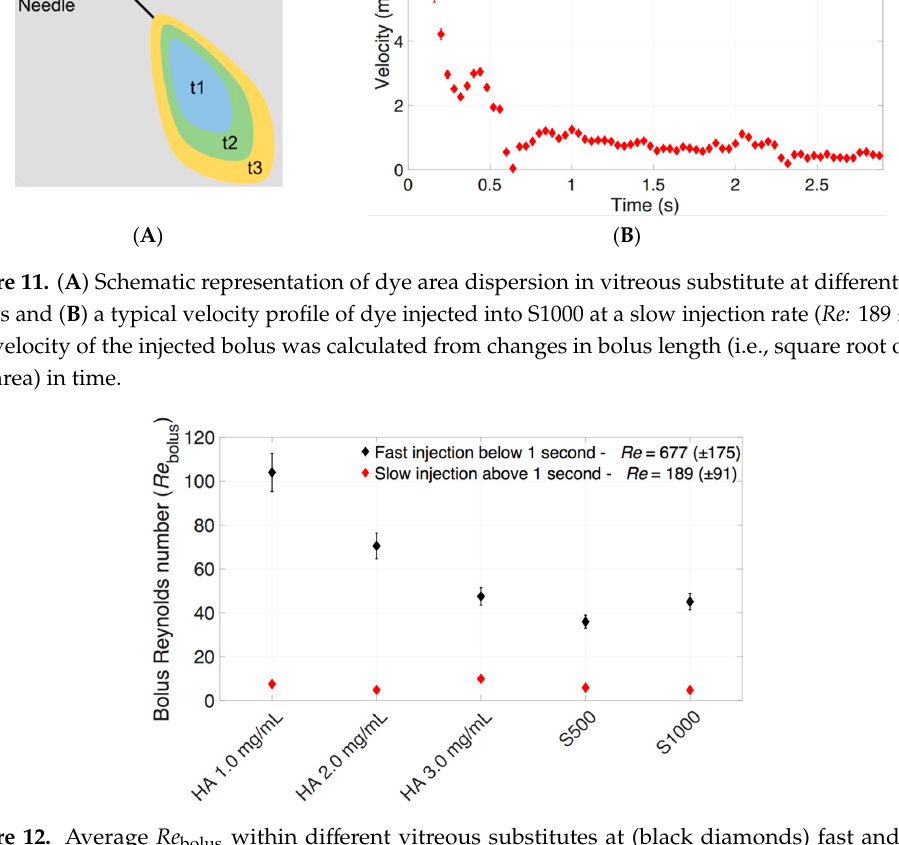
Figure 12. Average Re bolus within different vitreous substitutes at (black diamonds) fast and (red diamonds) slow injection rates.